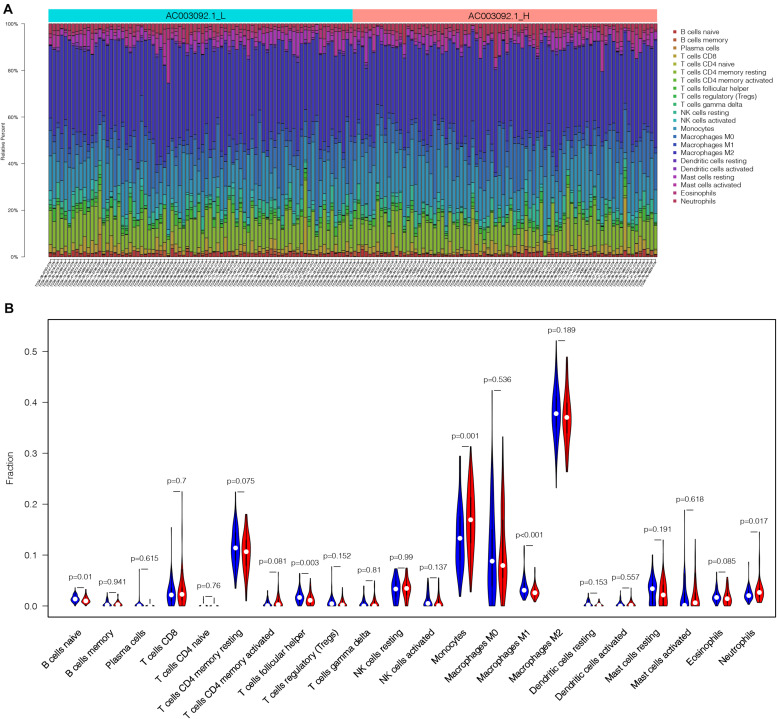
The landscape of infiltrating immune cells in AC003092.1_H and AC003092.1_L. (A) The bar plot of immune infiltration between AC003092.1_L and AC003092.1_H. (B) Comparison of the immune cell proportion between AC003092.1_H and AC003092.1_L by CIBERSORTx (Mann–Whitney U test).